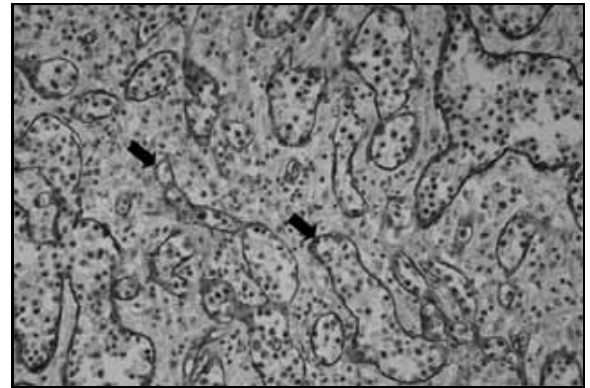
Figura 3 – Marcação com anticorpo anti CD34. As setas pretas indicam as células endoteliais dos capilares da glândula suprarrenal marcadas. No interior dos vasos,